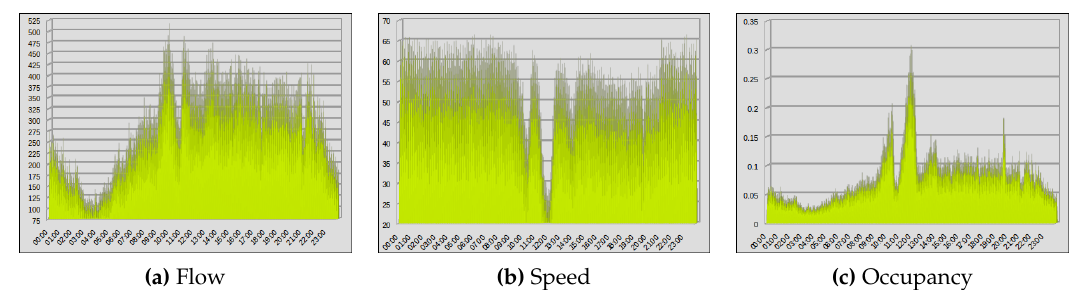
Figure 2. A depiction of vehicles data collected from PeMS (24 h) (November